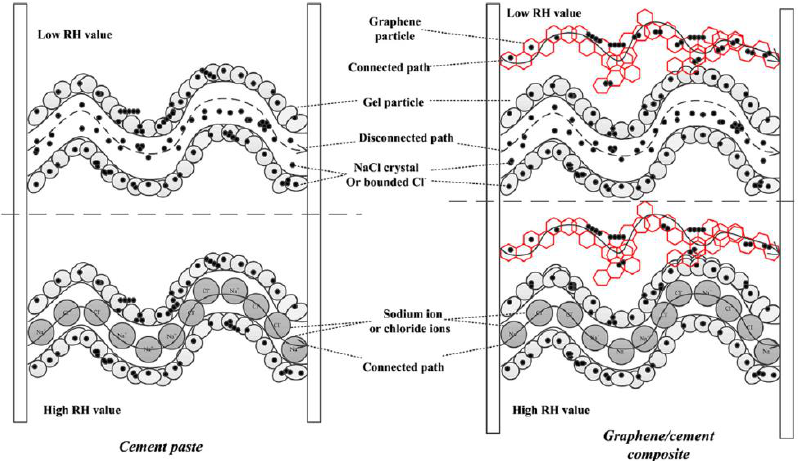
Figure 22. Formation of conductive paths in cement paste and GRCCMs. Reprinted with permission from Ref. [47]. Copyright 2017 Elsevier.